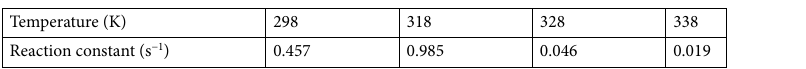
Table 3. Urea electrooxidation reaction constants at different reaction